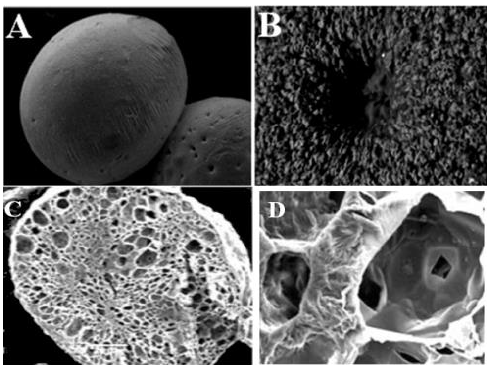
Figure 1. SEM image of alginate/lupin protein isolate complex beads with encapsulated cod liver oil at 150× magnification showing the outer aspect ( A ), the external surface details ( B ), the cross-section ( C ), and the microstructure ( D ).